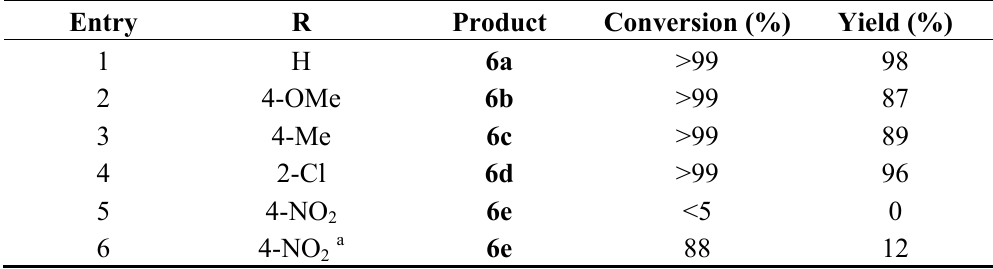
][Im] 4444 O (1.0 2